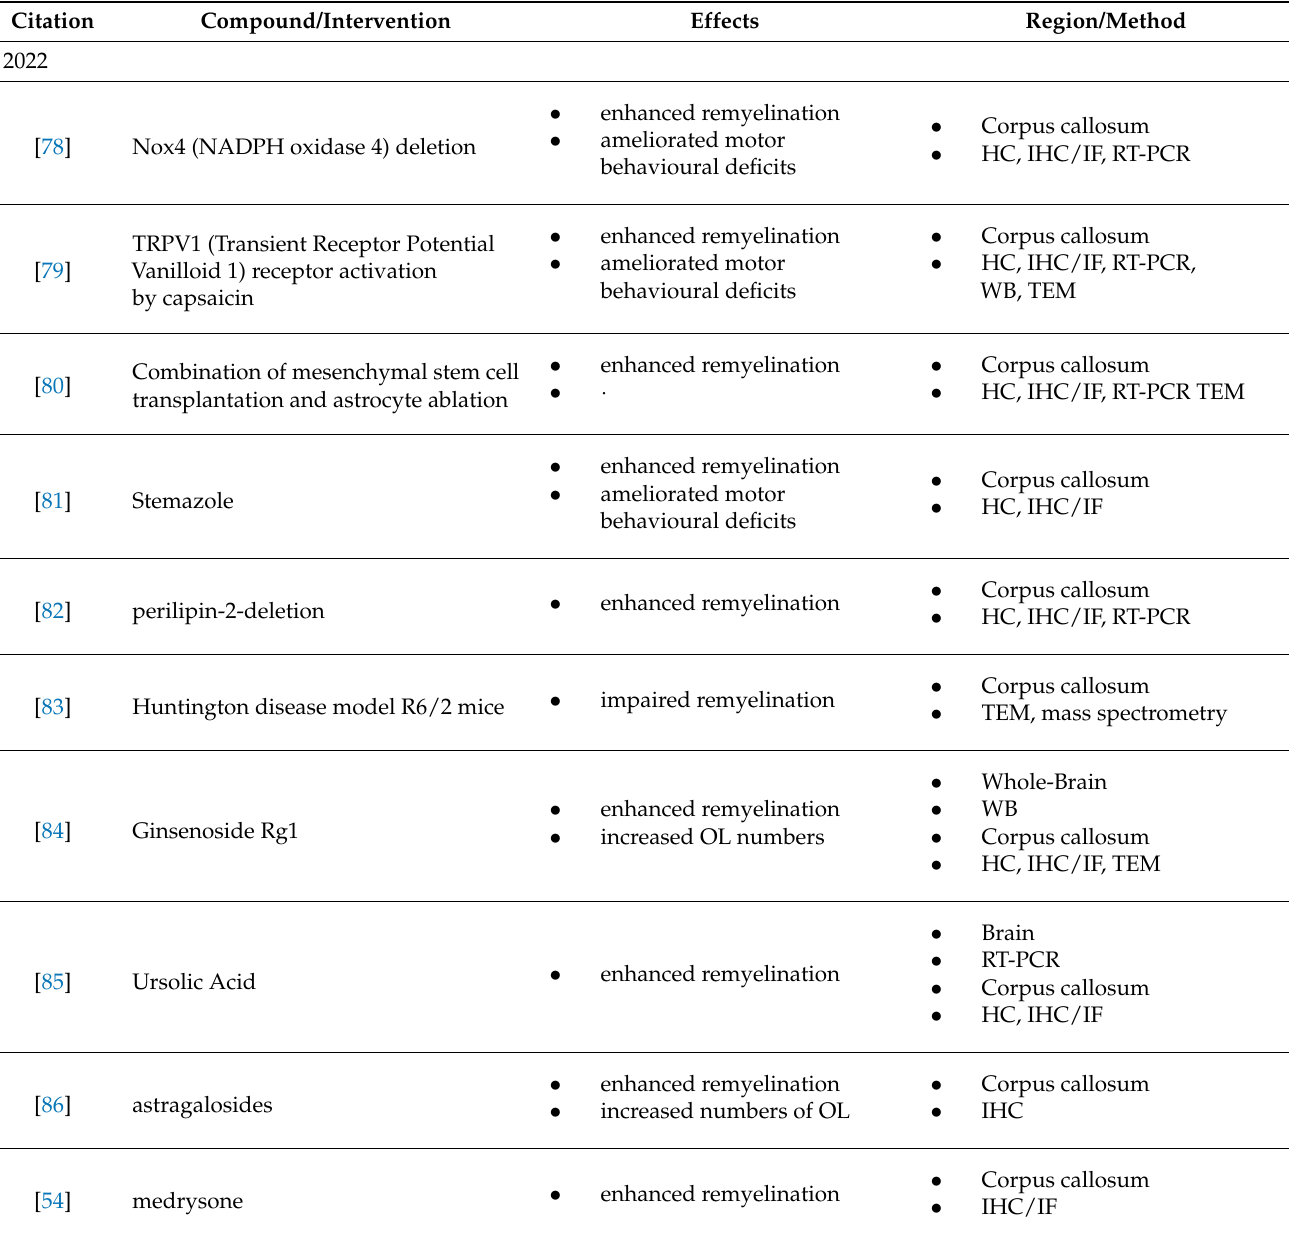
Table 1. Summary of publications using the cuprizone model to study which factors regulate remyelination. The terms “cuprizone” and “remyelination” were applied using the PubMed database. Manuscripts from 2016–2022 were included. HC = Histochemistry; IHC = Immuno- histochemistry; IF = Immunofluorescence; RT-PCR = reverse transcription polymerase chain reaction; WB = western blotting; TEM = transmission electron microscopy; MRI = magnet resonance imaging; FACS = fluorescence aided cell sorting, (sc)RNA-seq = (single cell)RNA-sequencing, RNA-isH = RNA in situ hybridization. The “*” in column “Citation” indicates that a clinical trial/clinical trials are either ongoing or have already been completed (information retrieved from ClinicalTrials.gov in December 2022; search terms used were “multiple sclerosis” and “the respective compounds”; no pathways were included in this